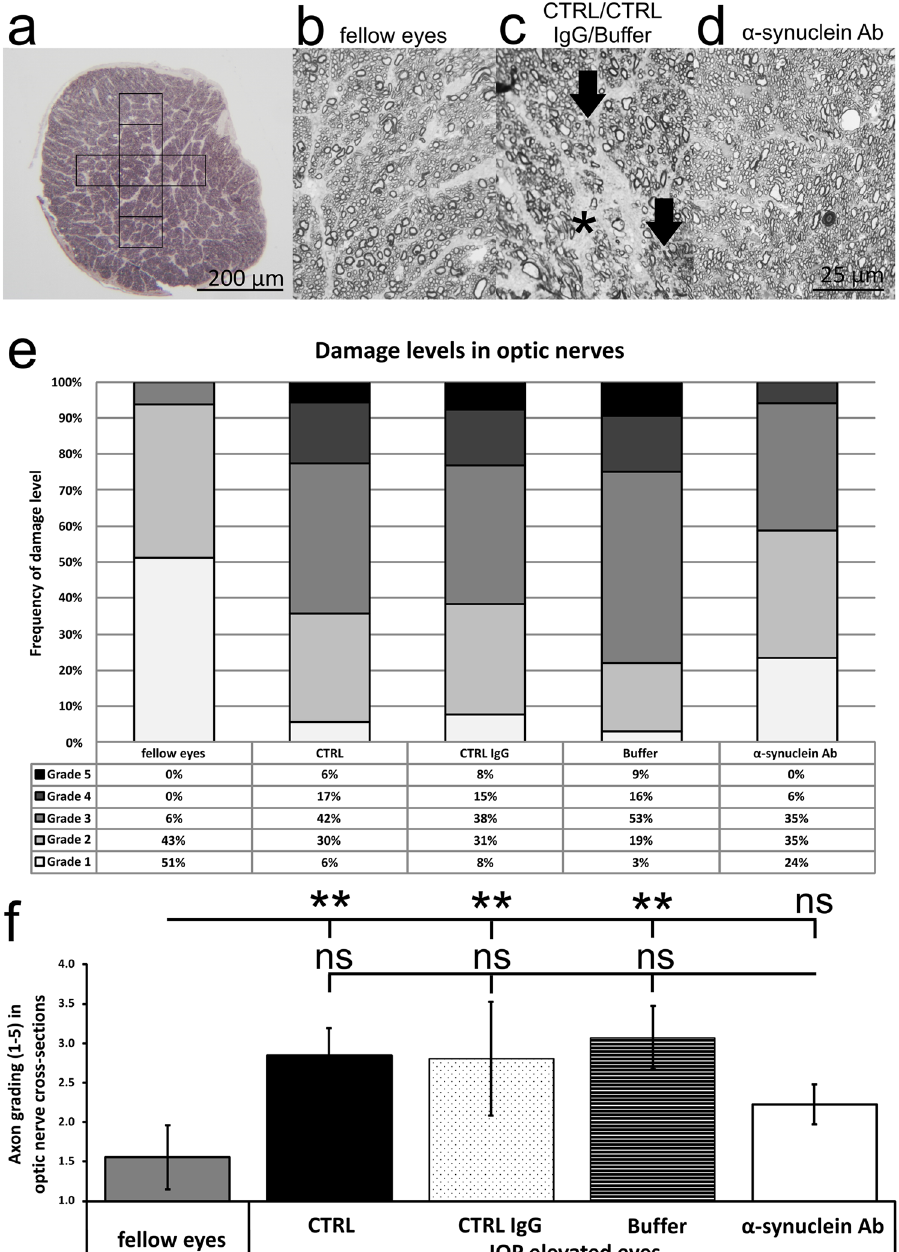
Figure 3. Survival of axon bundles in the optic nerve after IOP elevation. The degree of neurodegeneration was accessed by analysis of the optic nerve axonal damage levelin cross sections. ( a ) A representative low magnification image of an ultrathin optic nerve cross section. Six to seven images were taken for analysis. ( b–d ) Representative high resolution images of axons with different degrees of neurodegeneration, from healthy (fellow eyes, b ) to severely damaged (CTRL/CTRL IgG/Buffer, arrow indicate axons with collapsed myelin sheaths, star indicates glial scars, c ). IOP elevated eyes of α -synuclein Ab group showed slightly fewer damage ( α -synuclein Ab, d ). ( e ) Damage levels in optic nerves are arranged according to their damage grade (grade 1: healthy to grade 5: severely damaged). IOP elevated eyes of CTRL, CTRL IgG and Buffer group show the highest degree of neuronal degeneration, while degeneration was reduced in α -synuclein Ab group. ( f ) The statistical analysis revealed significantly elevated damage scores for CTRL, CTRL IgG and Buffer group compared with fellow eyes (indicated as ** For p < 0.01). Compared with α -synuclein Ab group, no significant differences could be observed to control groups (ns = not significant). Scale bars as